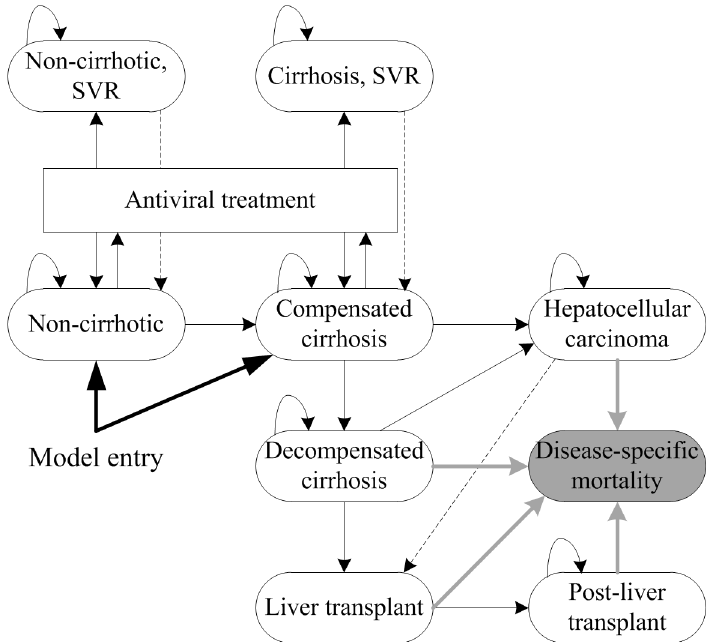
Fig 1. Structure of the Markov state transition model. Patients can transition from each health state to death from any cause.